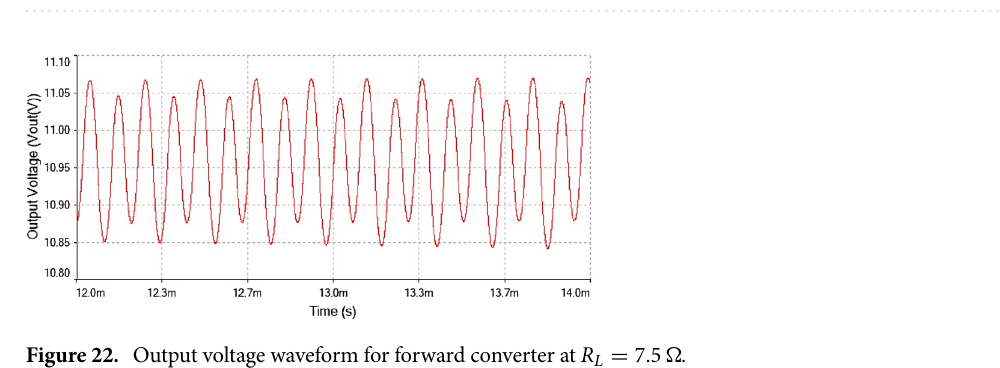
Figure 21. Phase portrait between I L vs V out at R L = 4 (cid:31) : period-1 attractor .